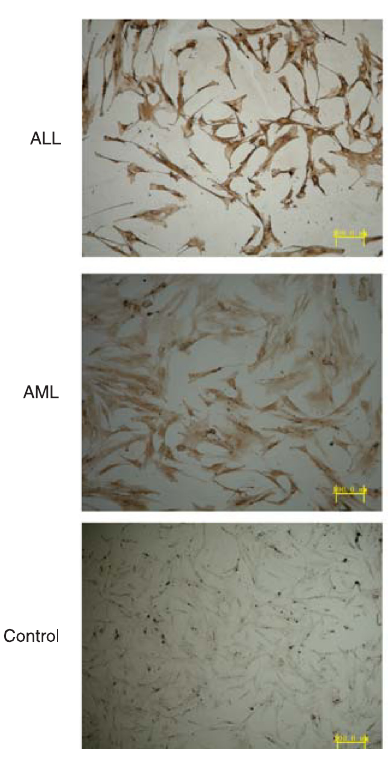
Figure 1. HIF-1α protein expression detected by immunohis - tochemistry. The HIF-1α-positive cells are shown stained brown. The levels of HIF-1α protein in the acute myeloblastic leukemia (AML) and acute lymphoblastic leukemia (ALL) groups were higher than in the normal control (P < 0.01, t -test).